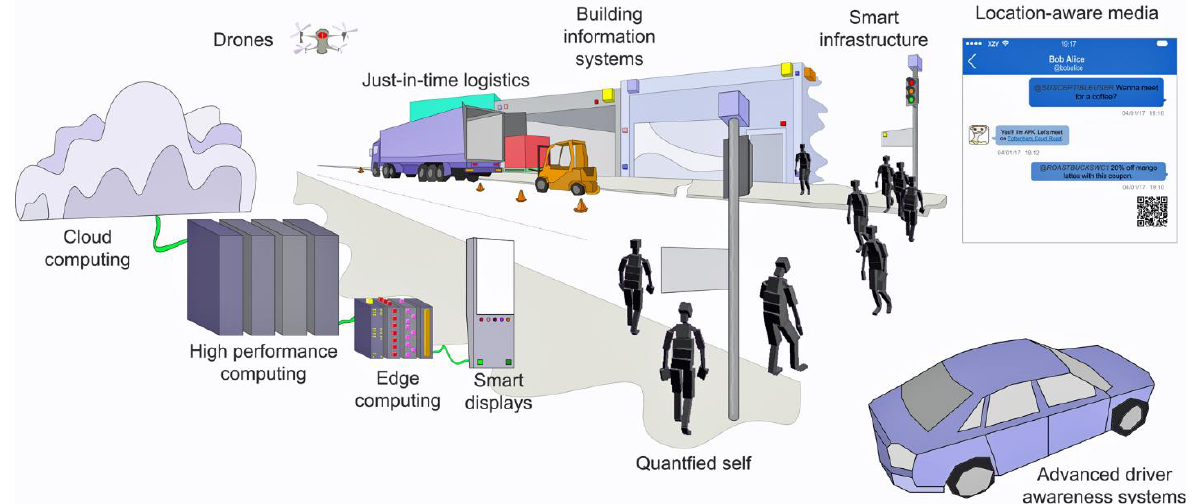
Figure 1. Facets of the smart and sentient retail high street.